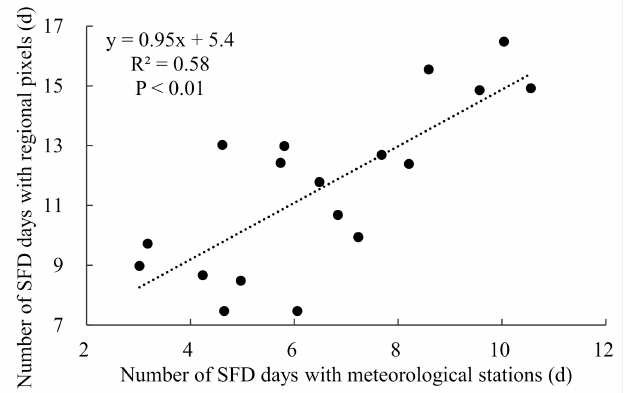
Figure 4. Scatter plot of SFD days retrieved from regional pixels and meteorological stations in